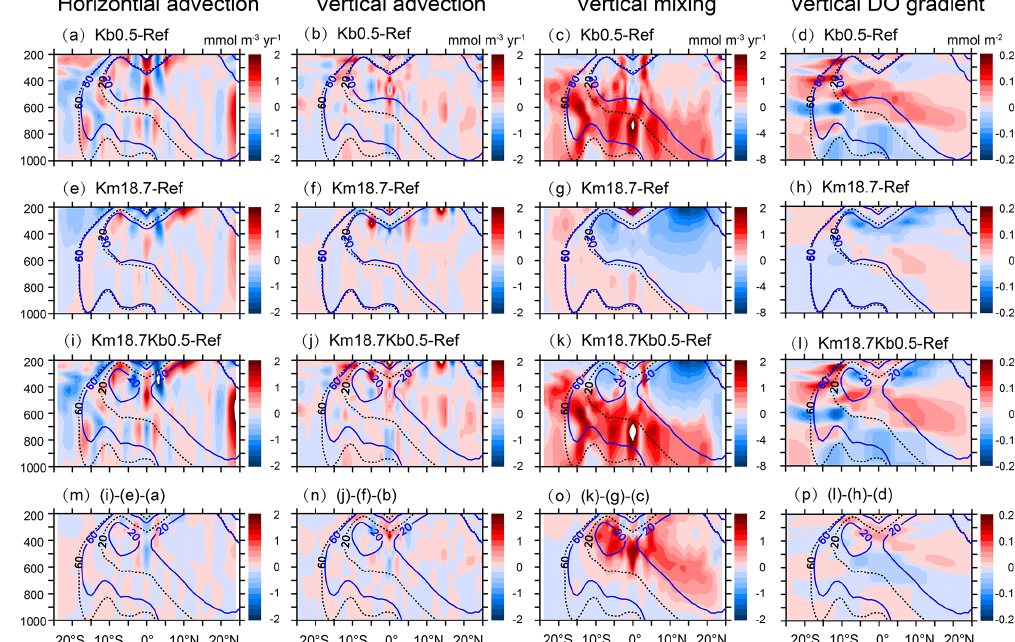
Figure 11. Changes in horizontal advection, vertical advection, vertical mixing, and vertical DO gradient over 120–90 ◦ W under an enhanced vertical mixing ( a, b, c, d ), a reduced O : C utilization ratio ( e, f, g, h ) and combination effects ( i, j, k, l ), and the residues or interactions ( m, n, o, p ). Black and blue lines denote contours of DO concentrations of 20 and 60mmolm − 3 from the reference run (dashed lines) and other simulations (solid